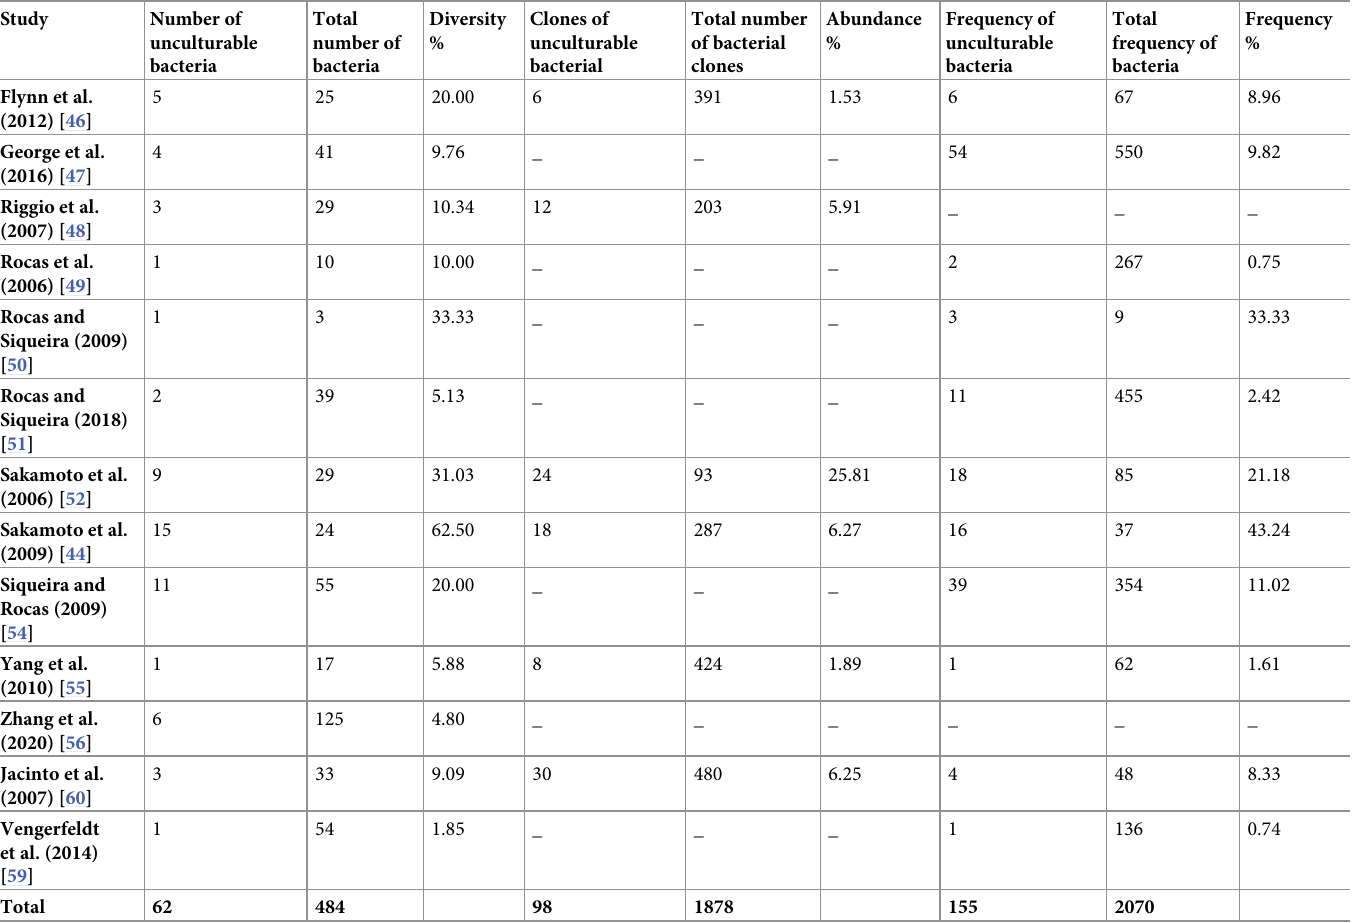
Table 2. Extracted results from each study of periapical